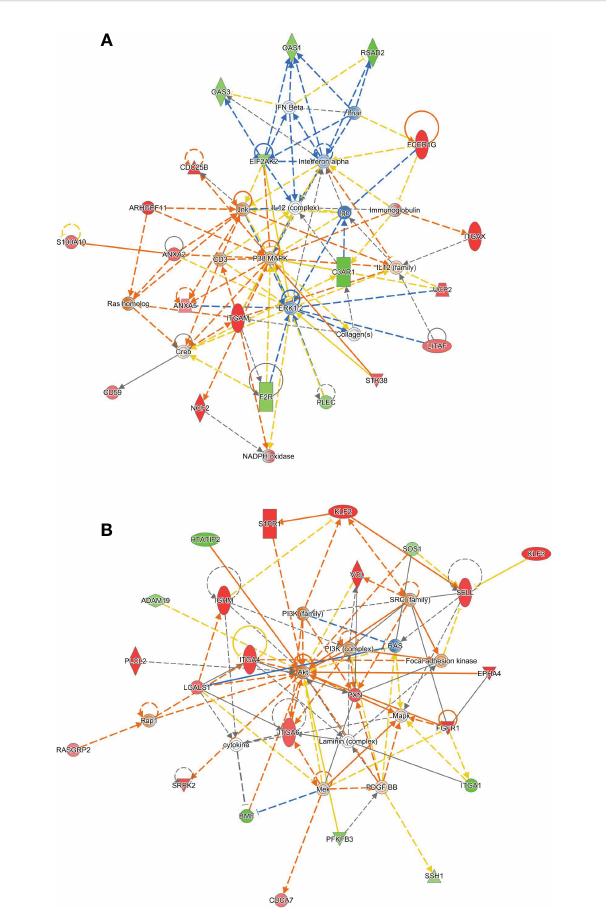
FIGURE 5 Ingenuity Pathways Analysis identi fi es two gene networks altered in HTATIP2 knockdown. Primary CD4 + T cells were obtained from three donors and transfected with non-targeting siRNA or an siRNA pool against HTATIP2. A paired differential gene expression analysis was used to identify changes in expression. (A) A network centered on a hub of MAP kinase signaling. Genes shown in green are downregulated; gene shown in red are upregulated. Solid lines are direct connections; dashed lines are indirect connections. (B) A network centered on PI3 kinase/AKT and cell